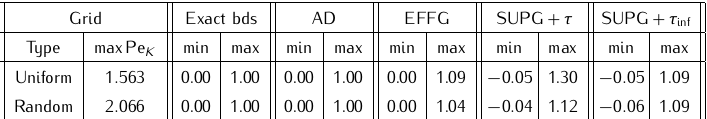
Table 2. Violation of the global solution bounds for the skew advection problem with ε uniform and randomly perturbed